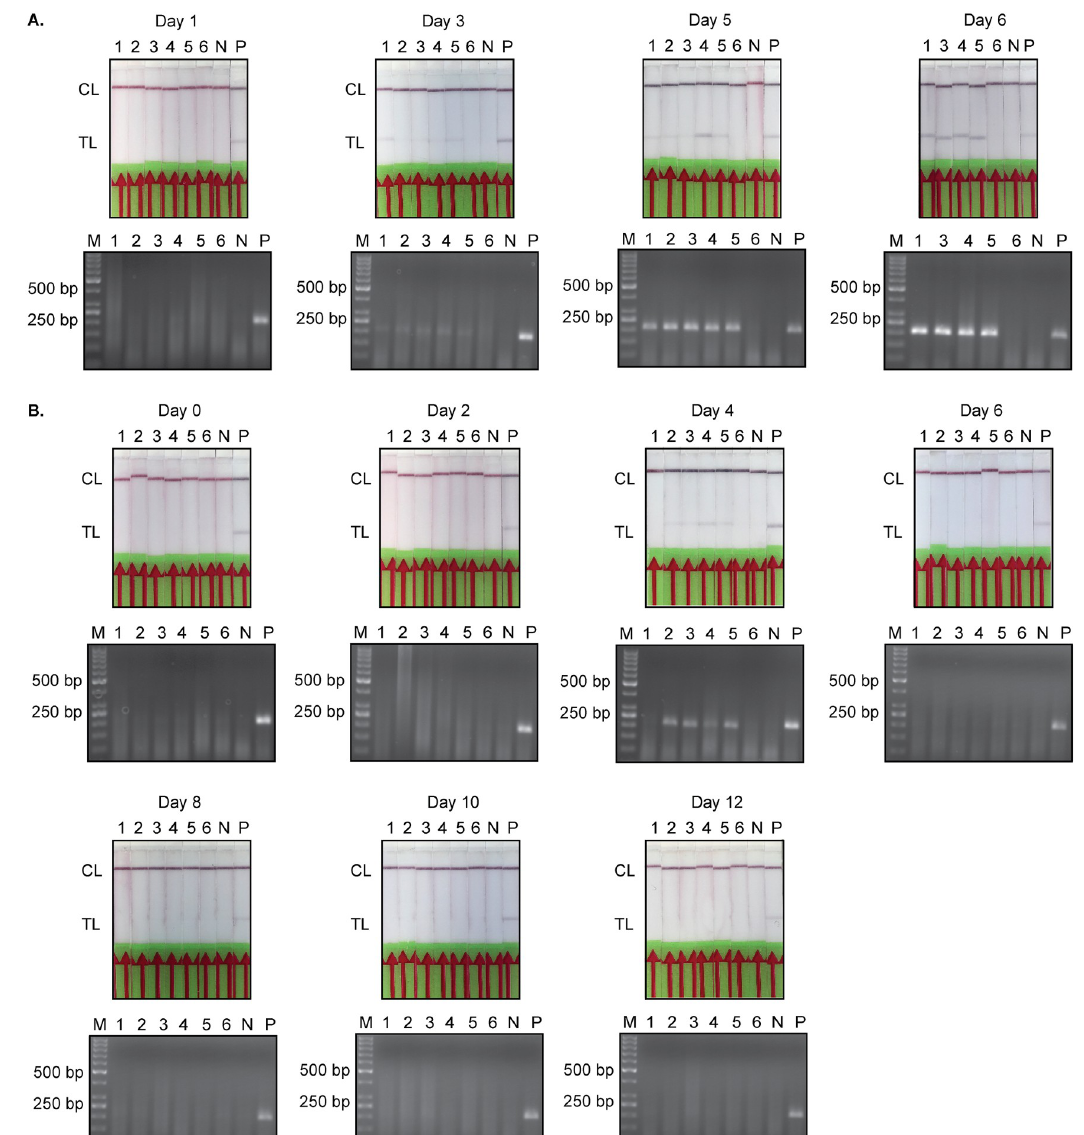
Fig 5. Tev PCR and Tev RPA-LF read-outs. The Tev PCR (bottom panels) and Tev RPA-LF (upper panels) read-outs displayed in Fig 4. A: Tev PCR and Tev RPA-LF results for the mouse infection trial of Group 1 mice (corresponds to the data set shown in Fig 4A). B: Tev PCR and Tev RPA-LF results for the mouse infection trial of Group 2 mice (corresponds to the data set shown in Fig 4B). In all panels Lane M indicates the molecular mass marker, Lanes 1-6 indicate the individual mice (mouse 6 was used as a negative control within each data set and was not infected), Lane N is a negative control sample (no template DNA) and Lane P is the positive control ( T. evansi purified genomic DNA). CL and TL refer to the control and test lines, respectively.